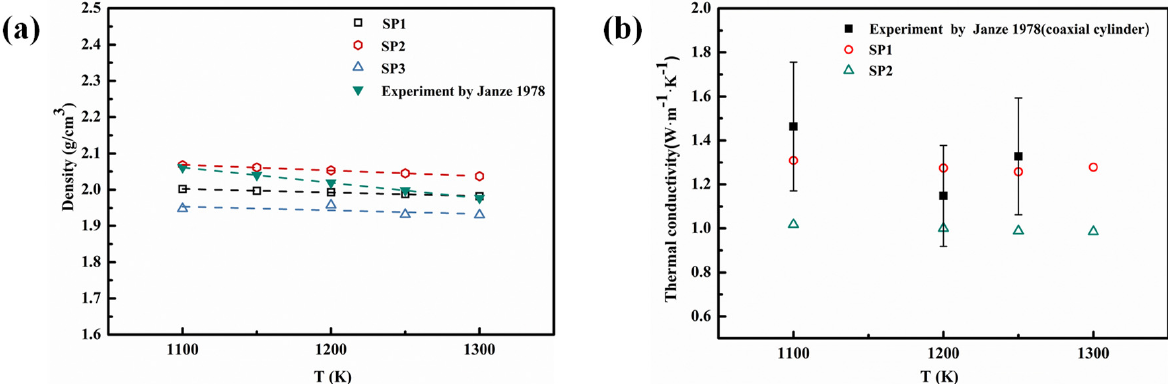
Figure 2. ( a ) Density of CaCl 2 varies with temperature; ( b ) Thermal conductivity of CaCl 2 changes with temperature